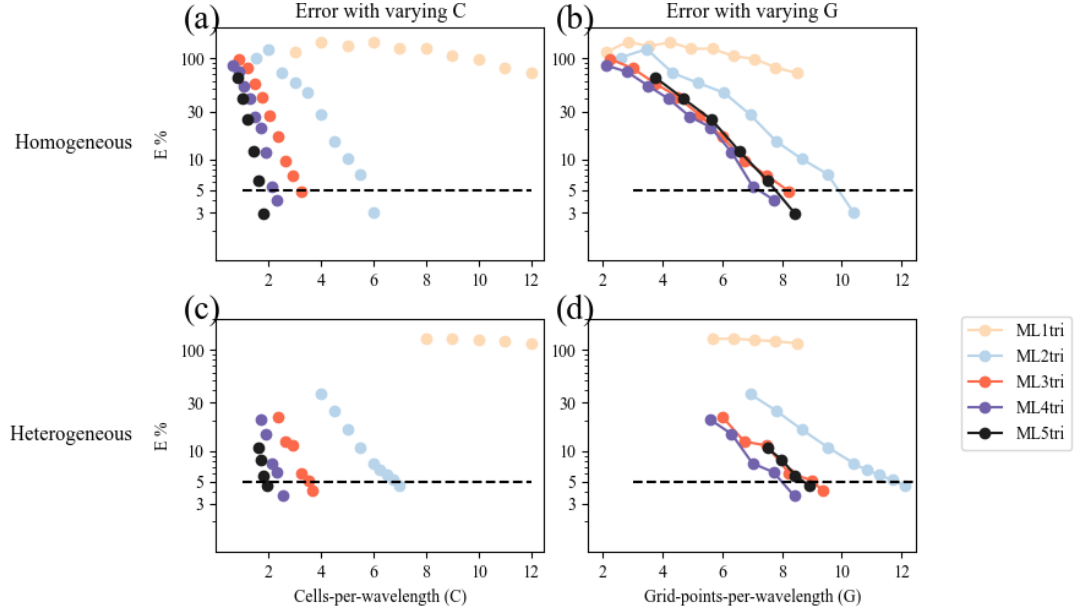
Figure 8. Panels (a) and (b) depict results for the homogeneous velocity model experiment to find the minimum G (Sects. 5.2.2 and 5.2.3). Panel (a) shows C as a function of E (Eq. 40). Panel (b) illustrates the E as a function of G . Panels (c) and (d) show the same thing as panels (a) and (b) but for the heterogeneous velocity model experiment. Colored lines represent the spatial polynomial order of the element. The E = 5% threshold is drawn as a horizontal dashed black line on all